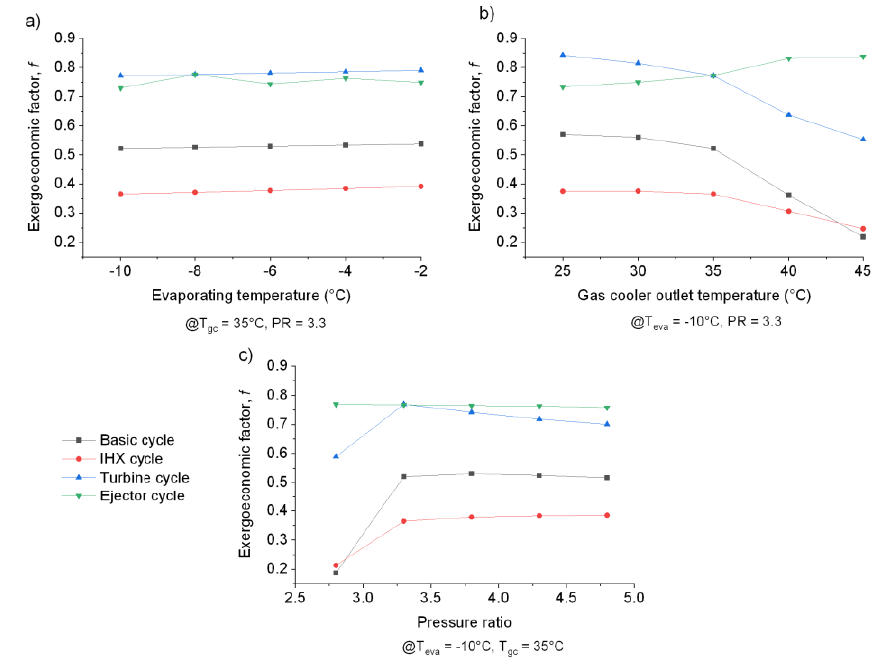
Figure 8. Variations of the exergoeconomic factor, f , due to: ( a ) the evaporating temperature; ( b ) the gas cooler outlet temperature; ( c ) the pressure ratio.